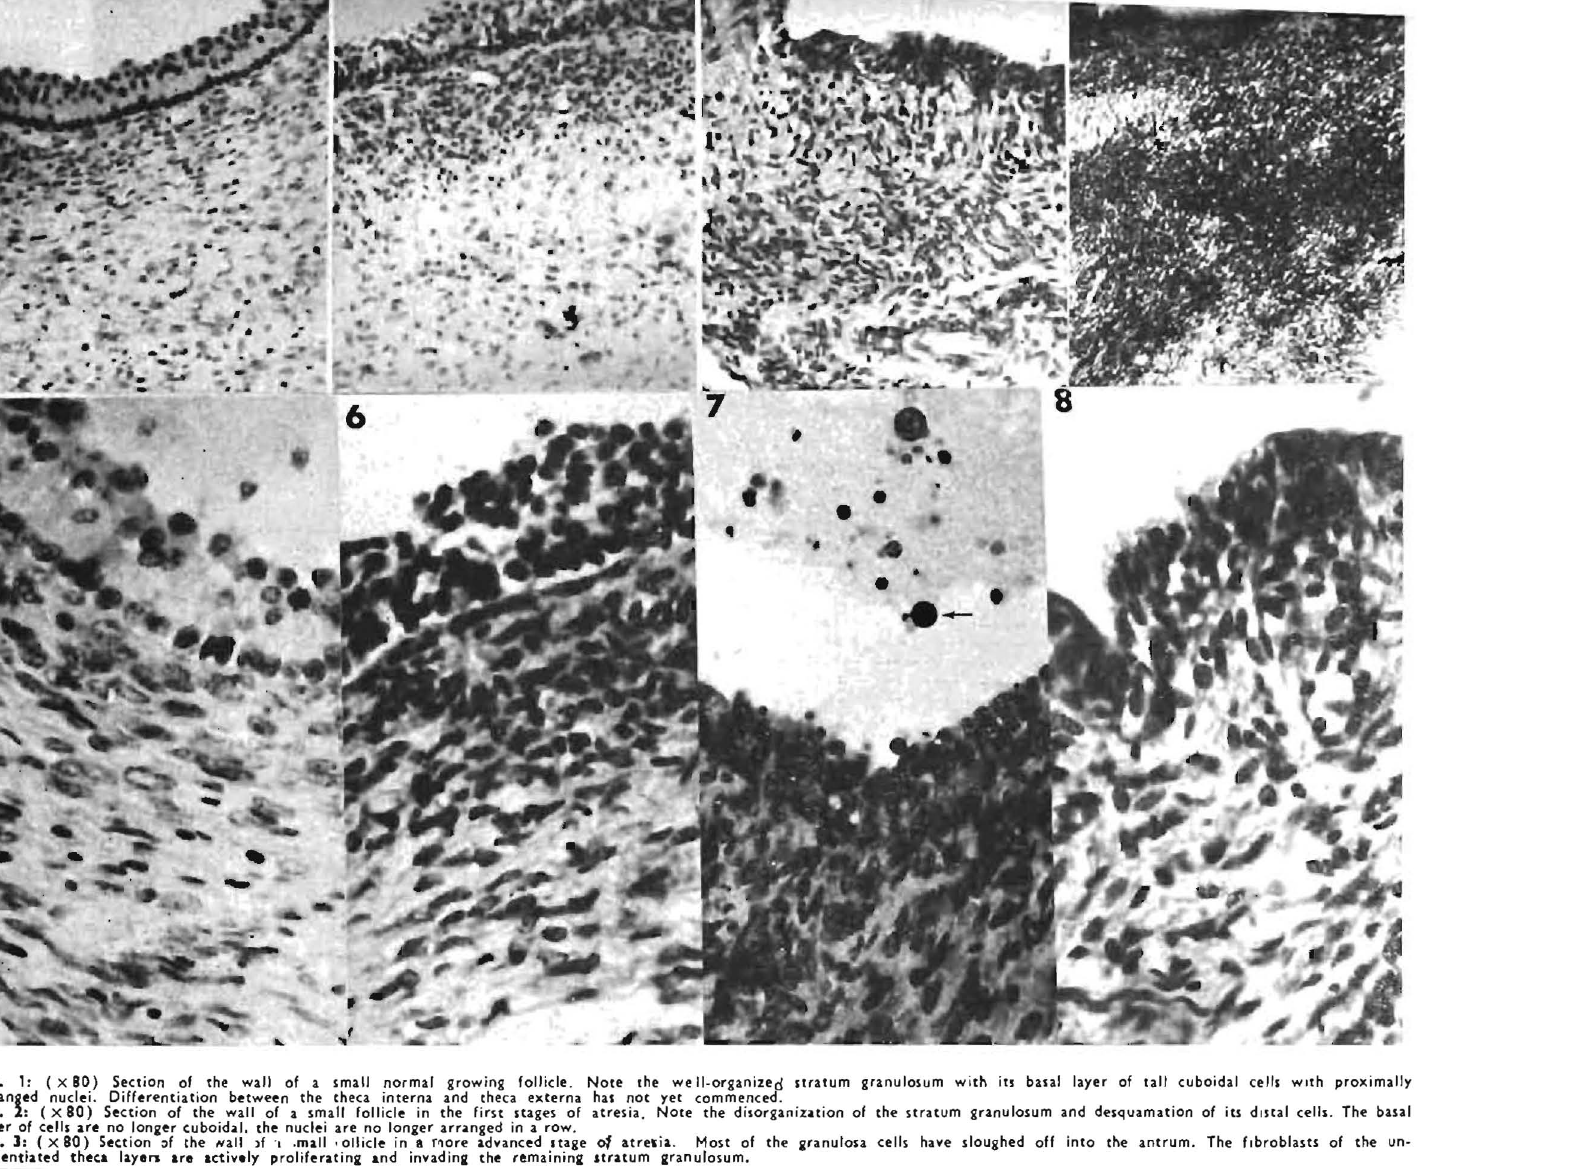
Fil. 1: (x 90) Section of the wall of a small normal growing follicle. Note the we II-organized s:tratum granulosum with in bani layer of tall cuboidal cells: with proximally arranled nuclei. Differentiation between the theca interna and theca externa hu not yet commenced. FII_ 2: (x 80) Section of the wall or a smaff follicle in the first Hages of atresia. Note the disorganizuion of the uratum granulosum and desquamation of its dunl cells. The bual layer of ceUs are no lonaer cuboidal. the nudei are no Jonier arranged in a row. FII. l: (x 80) Section ,r the Nail )f 'I .mall . ollicle in &. f"lOre advanced luge of atrelia. Most of the aranulosa cells have sloughed off into the antrum. The fIbroblasts of the un diffentiated theca laye,... afe actively proliferatina and invadina the remainina stratum